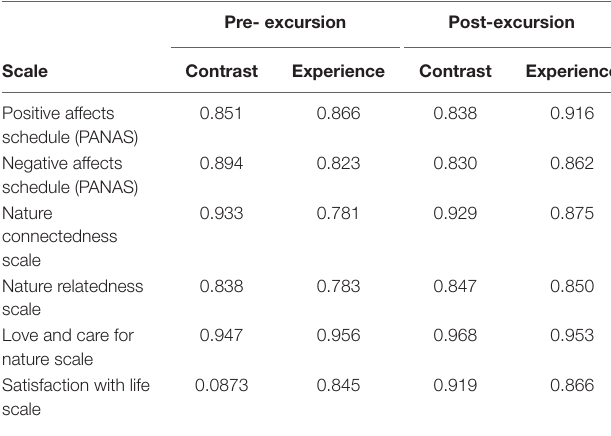
TABLE 1 | Cronbach’s Alpha reliability